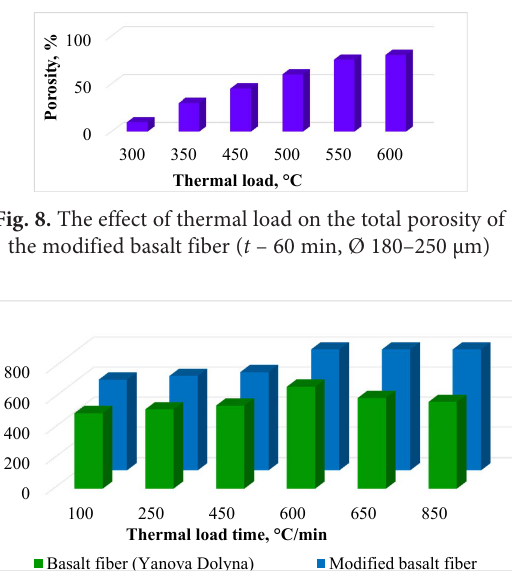
Fig. 7. The placement of active zones on the surface of basalt fiber